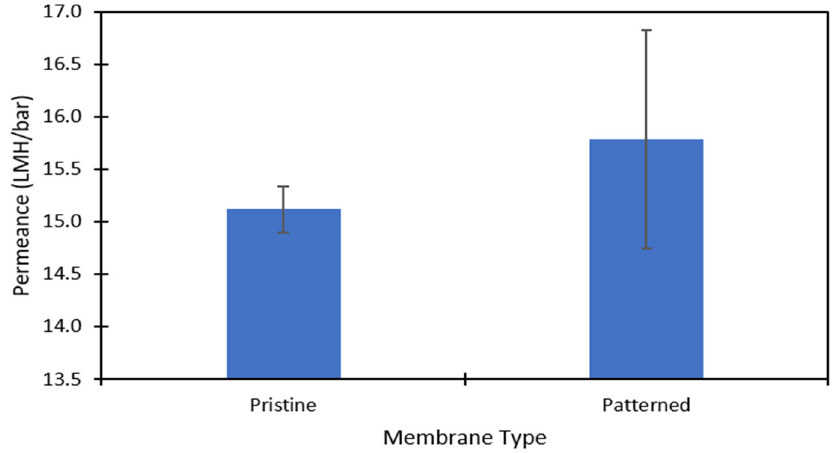
Figure 3. The pure water permeance (LMH/bar) data for the pristine and patterned membranes. The data was collected at 6.89 barg. The error bars represent one standard deviation among at least three membrane samples.